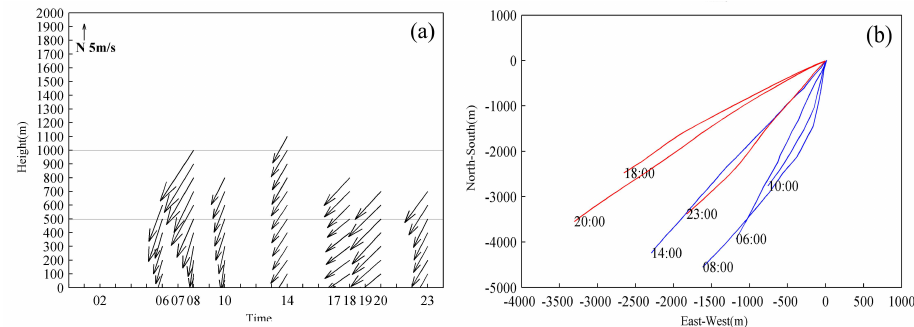
Fig. 7. Vertical wind profiles obtained using radio soundings and balloon trajectories on 26 October 2004 at the Xinken station.